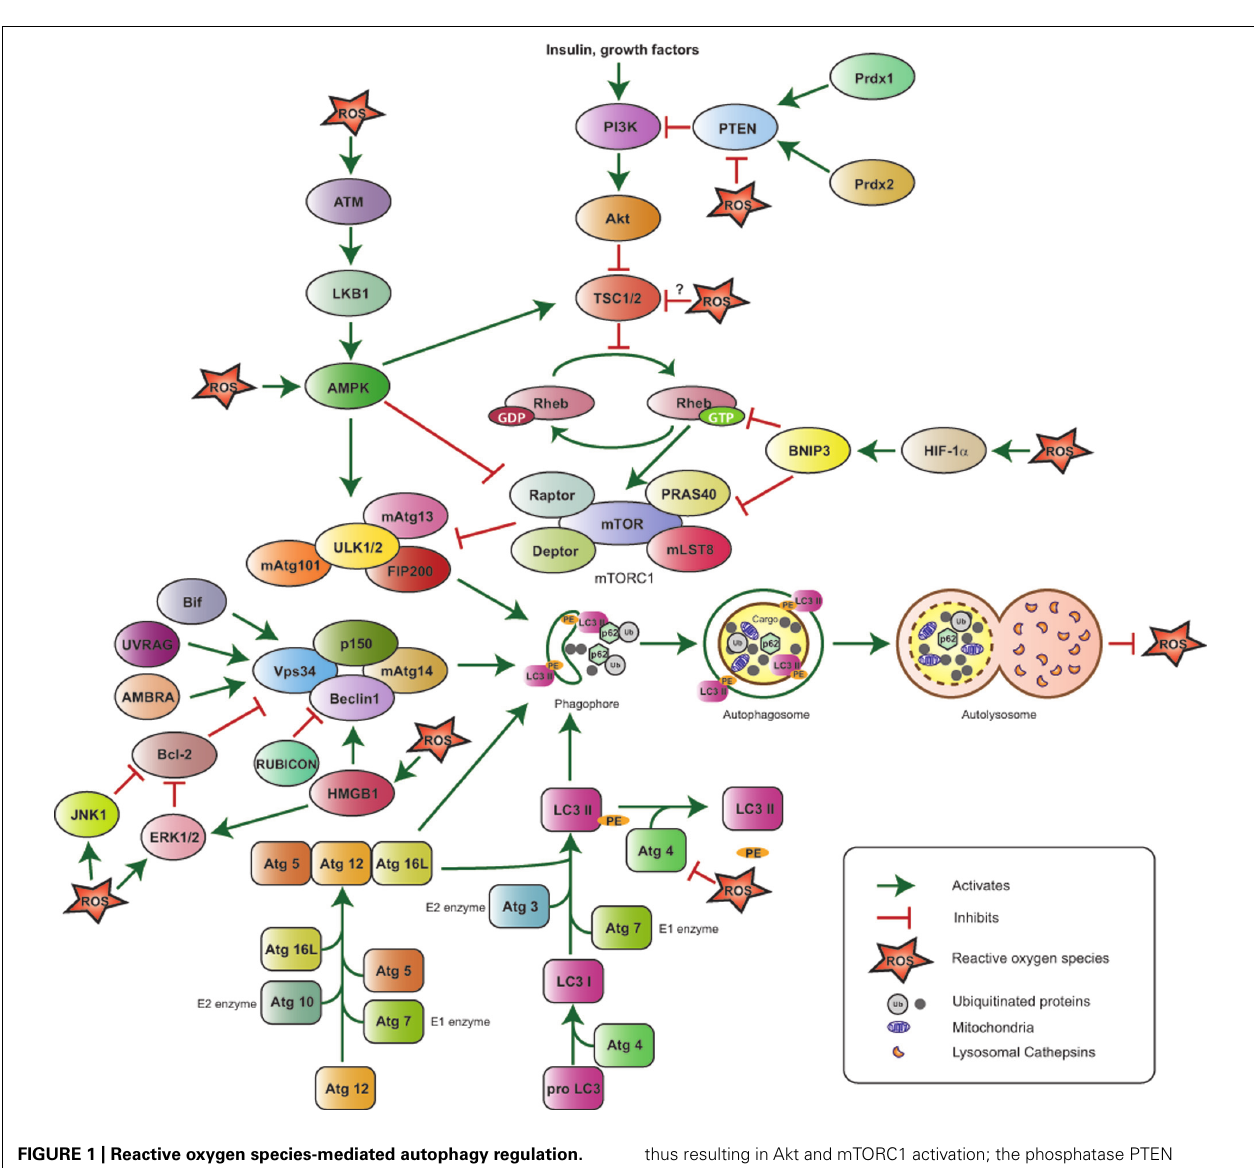
FIGURE 1 | Reactive oxygen species-mediated autophagy regulation. The ULK1/2–FIP200–mAtg13 and Beclin1–Vps34–p150 protein complexes together with the two ubiquitin-like proteins Atg12 and LC3 (or Atg8) and their conjugating proteins, including Atg7 (E1-like enzyme), Atg10 (E2-like enzyme), and Atg3 (E2-like enzyme), are the primary regulators of autophagosome formation and, thus, autophagy induction. Atg4 cleaves Pro-LC3 at its C-terminal-end, Atg7 and Atg3 add phosphatidyl ethanolamine (PE), and LC3-PE is then incorporated into the autophagosome membrane; Atg4 can also cleave LC3-PE to release free LC3 and negatively impact autophagy.The PI3K–Akt–mTORC1 pathway suppresses autophagy by inhibiting the ULK1/2–FIP200–mAtg13 complex. PI3K is activated in response to hormones and growth factors and suppressesTSC1/2